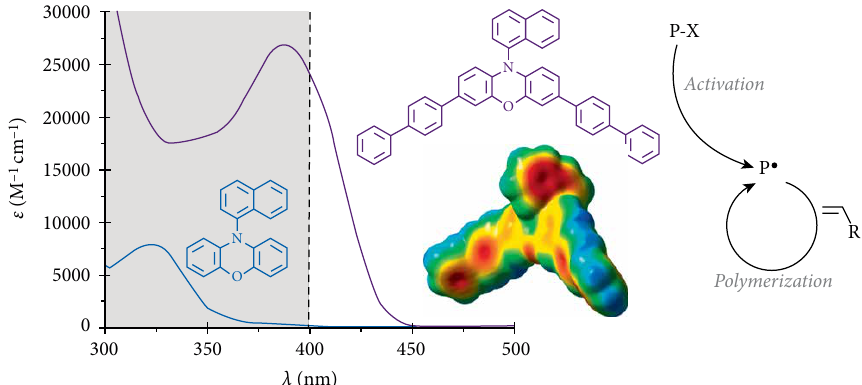
Figure 7: Structure, ESP mapped electron density of UV–vis spectrum of the visible light absorbing phenoxazine and the proposed mechanism. (Adapted with permission from Ref. [47]).